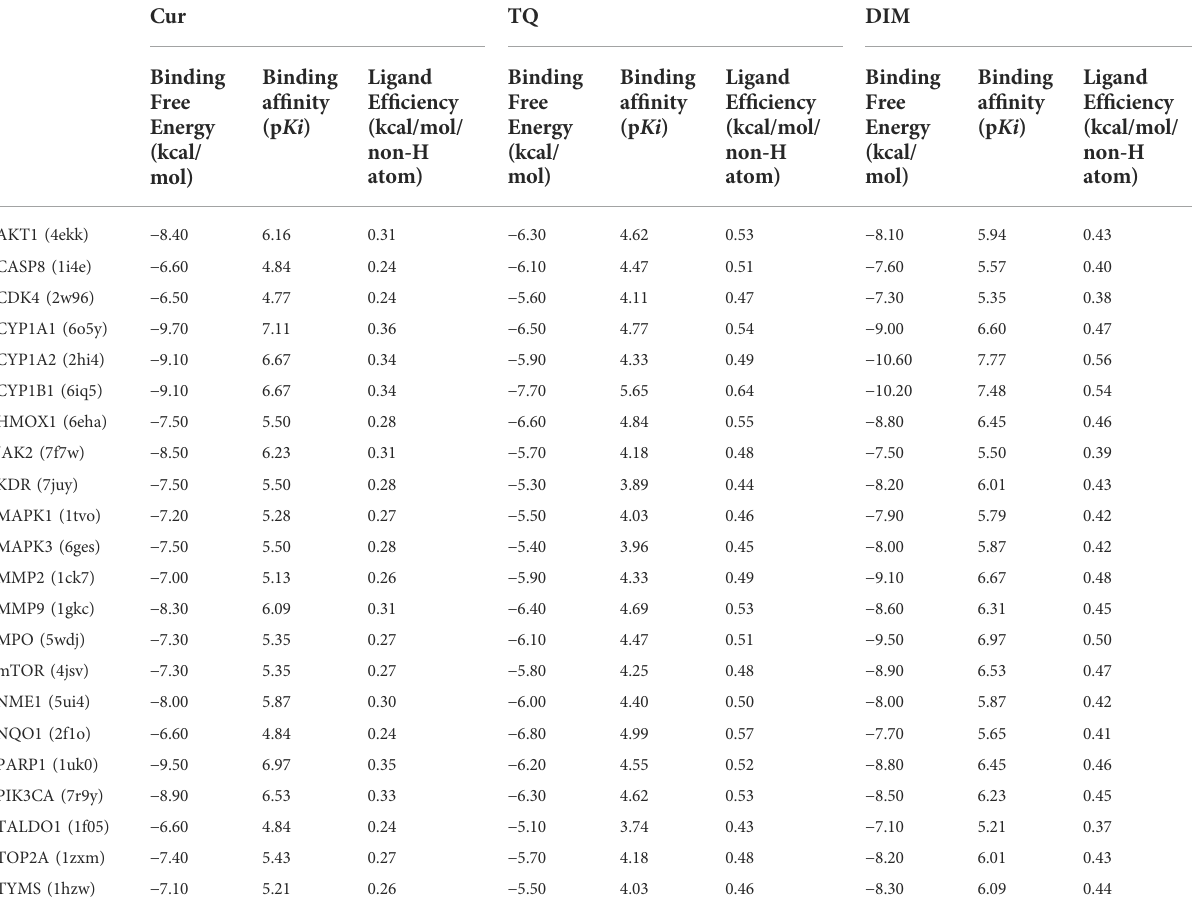
TABLE 3 Docking score of curcumin (Cur), thymoquinone (TQ), and 3, 3 9 -diindolylmethane (DIM) against some of their common